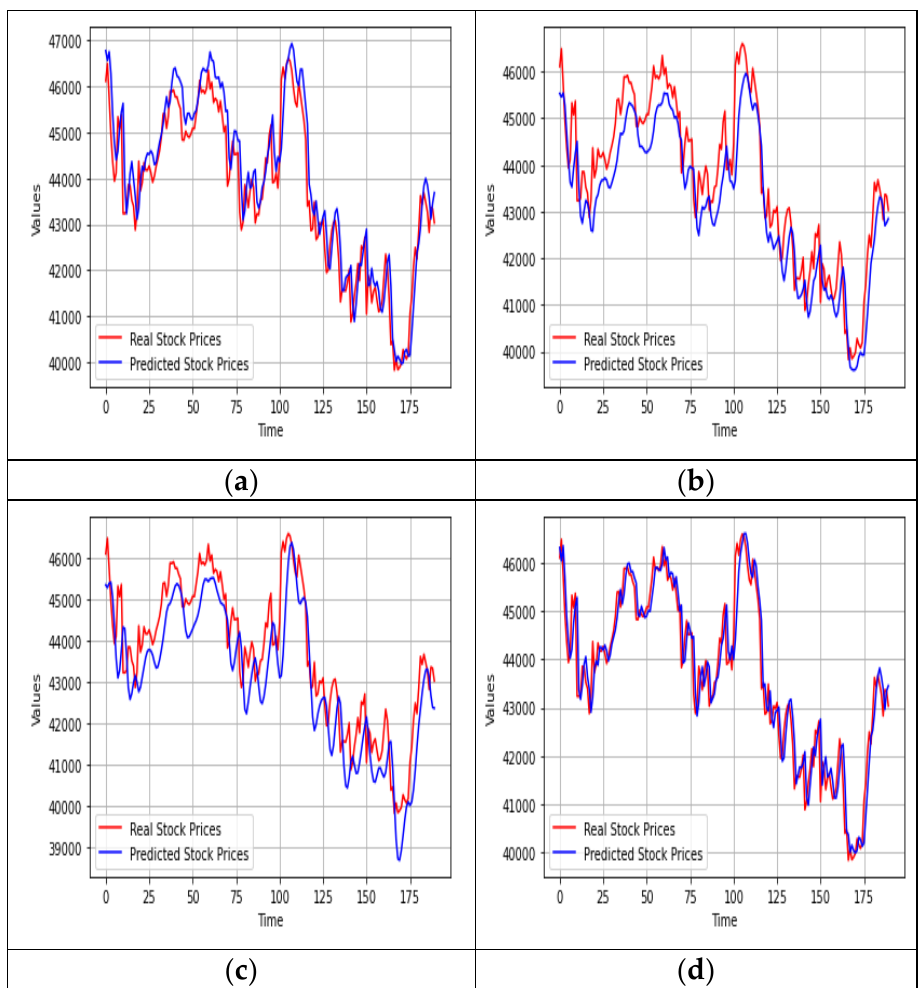
Figure 10. Prediction results of ( a ) EMD-LSTM ( b ) EEMD-LSTM ( c ) SEMD-LSTM ( d ) Proposed Akima-EMD method.